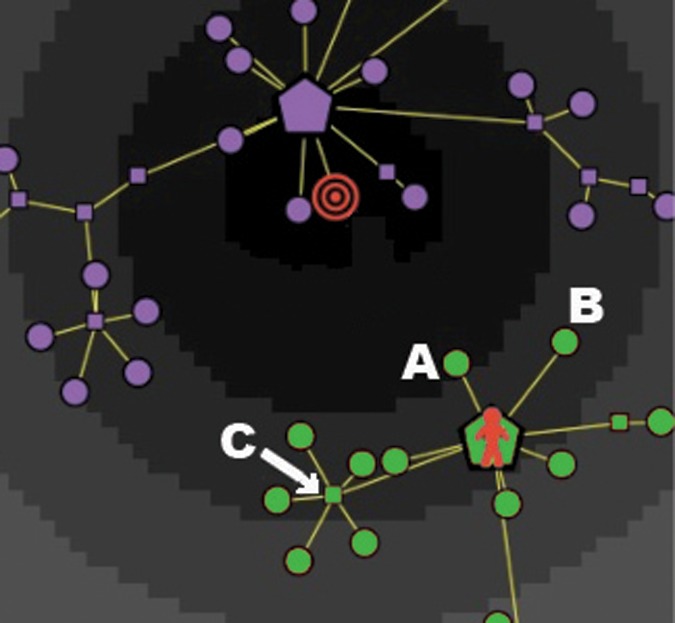
Dynamical rules determining the buyer’s next move: the case of high awareness.The consumer is well aware of the target, and tries to approach it by exploiting her high discrimination ability.